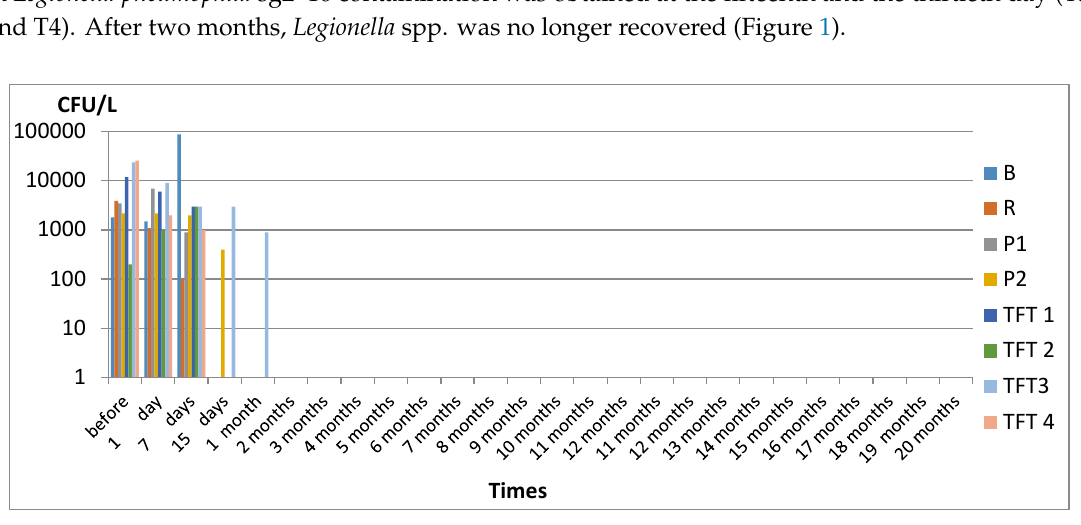
Figure 1. Legionella pneumophila sg2–16 counts at all the sampling points during the whole period of the study in Hospital 1. B = boiler; R = recirculation; P1 = point 1; P2 = point 2; TFT1 = time flow tap 1;